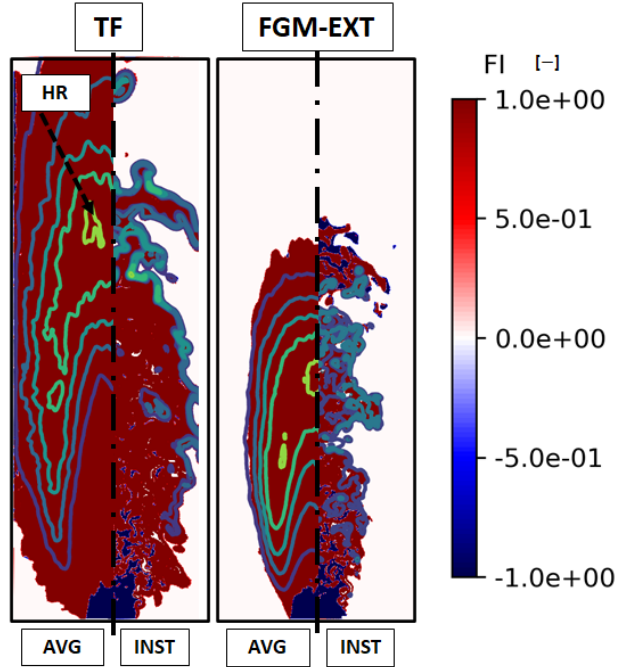
Figure 15. Contour maps of instantaneous and mean field of Flame Index FI for the TF ( left ) and the FGM-EXT ( right ) models.